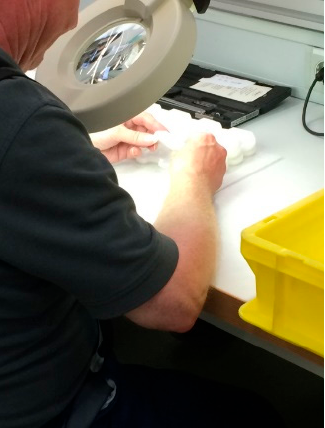
Figure 7. Unpadded position of the elbow and forearm creating risk of medial epicondylitis and ulnar nerve compression. nerve